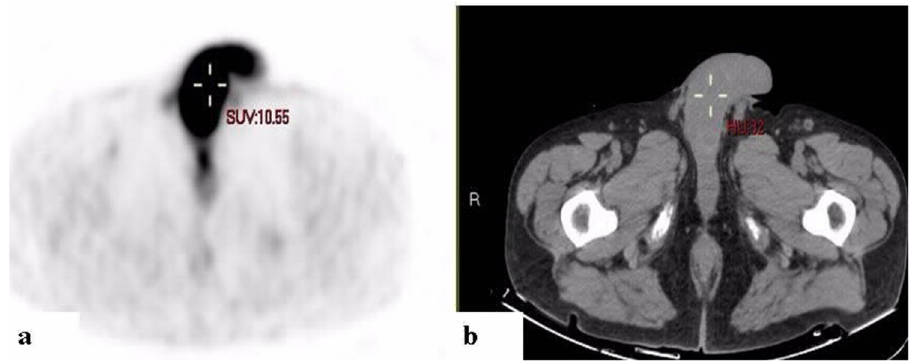
Figure 2. 18F-FDG PET ( a ) and CT ( b ) axial slices demonstrating diffusely increased uptake along the penis. A 73-year-old man with relapse of diffuse large B-cell lymphoma (patient #16, Table 1).